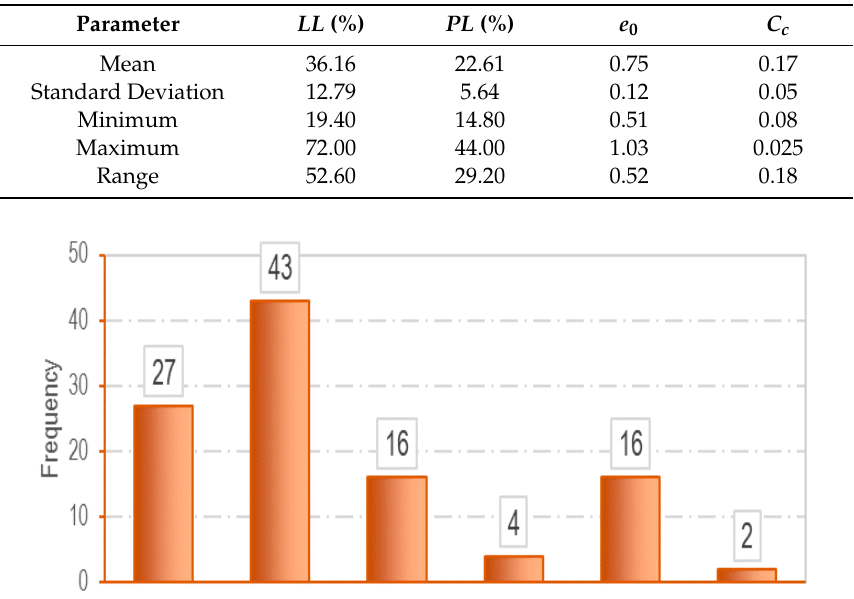
Figure 2. Distribution of LL .